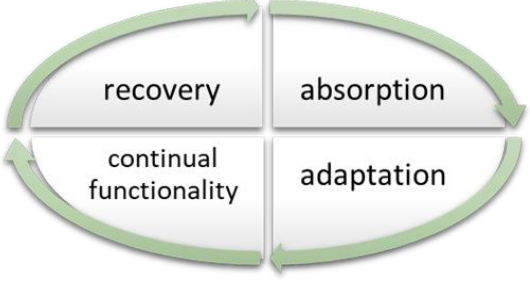
Figure 2. Keywords for resilience